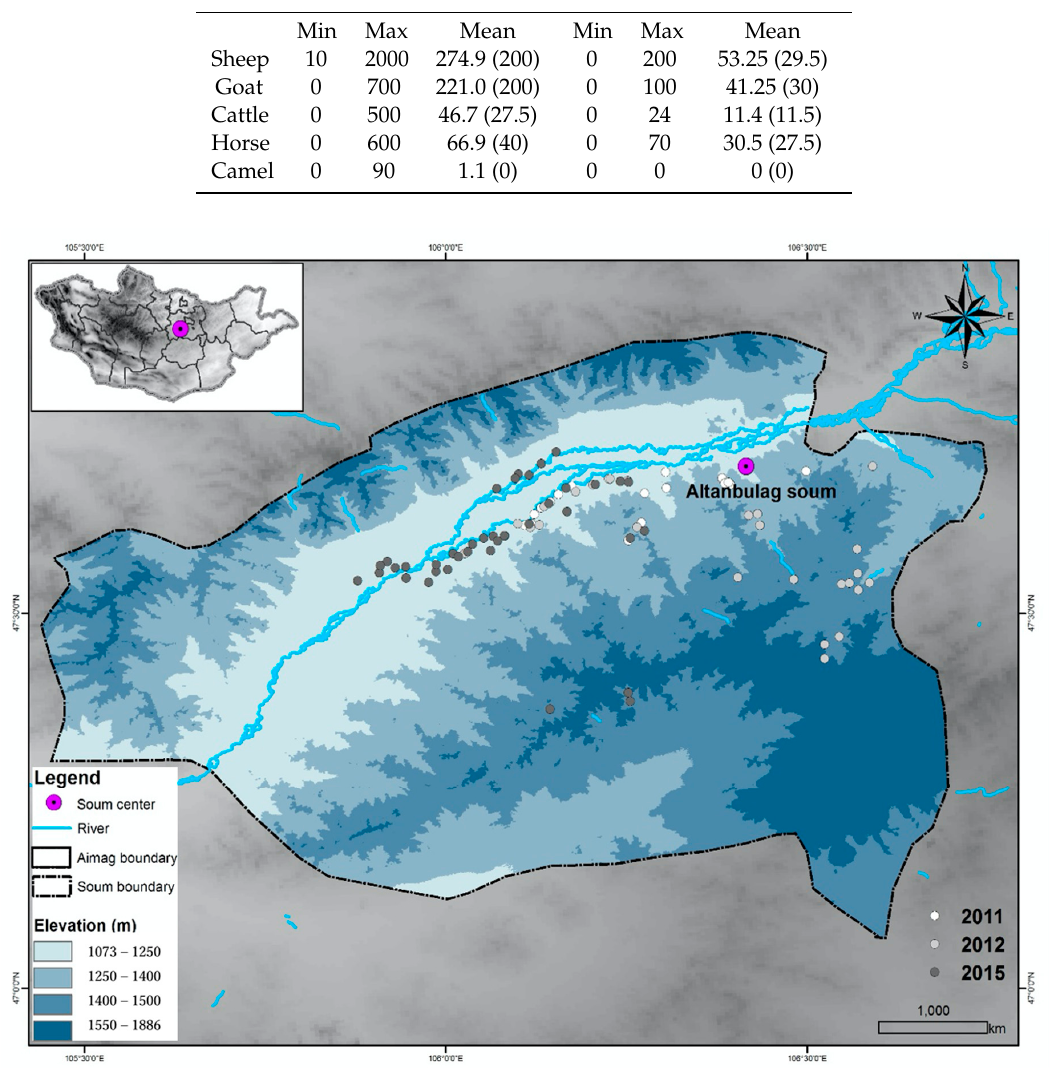
Figure 2. Spatial distribution of the summer camps in the Altanbulag soum ( n = 95).